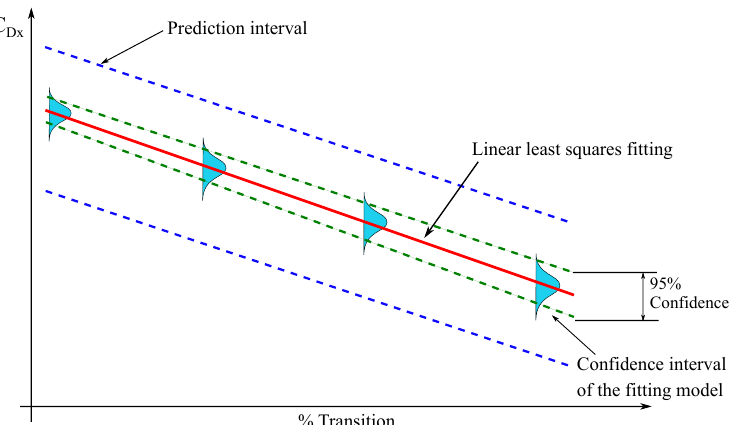
Figure 2. Prediction and confidence interval.